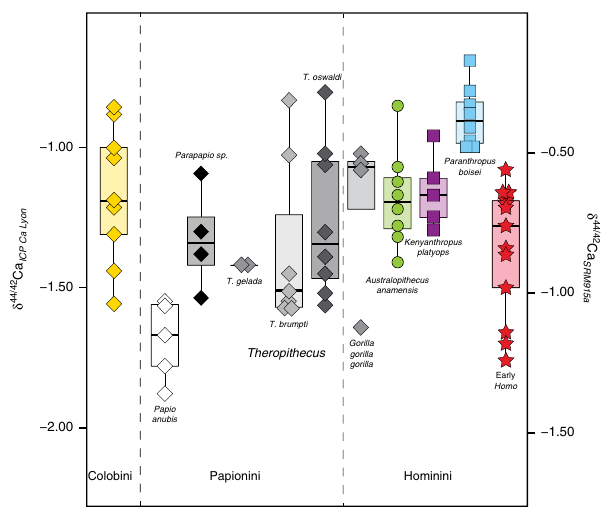
Fig. 1 Box and whisker plots showing the distribution of δ 44/42 Ca values (in ‰ ) between the various non-hominin and hominin primates analyzed in this study as well as some modern representatives ( Papio anubis , Theropithecus gelada, and Gorilla gorilla gorilla ). Note the 44 Ca-enriched isotope values of Paranthropus boisei in comparison to other groups. The boxes represent the fi rst and third quartiles with the medians as horizontal lines. The lower and upper whiskers represent 1.5 * the interquartile range (numbers of biologically independent samples per group: n = 9 for Colobini; n = 5 for Papio anubis ; n = 4 for Parapapio sp.; n = 2 for Theropithecus gelada ; n = 7 for Theropithecus brumpti ; n = 8 for Theropithecus oswaldi ; n = 4 for Gorilla gorilla gorilla ; n = 8 for Australopithecus anamensis ; n = 5 for Kenyanthropus platyops ; n = 8 for Paranthropus boisei ; n = 13 for early Homo ). Welch ’ s one-way ANOVA and Kruskal – Wallis tests show signi fi cant differences of average means (Welch ’ s one-way ANOVA on all groups except the two T . gelada individuals: 10 groups with a total of 71 biologically independent individual samples, p value < 10 − 4 , F = 11.7, df = 9; Kruskal – Wallis on all groups: 11 groups with a total of 73 biologically independent individual samples, p value = 0.0005, df = 10). δ 44/42 Ca values are expressed both against ICP Ca Lyon (left) and SRM915a (right). Source data are provided as a Source Data fi